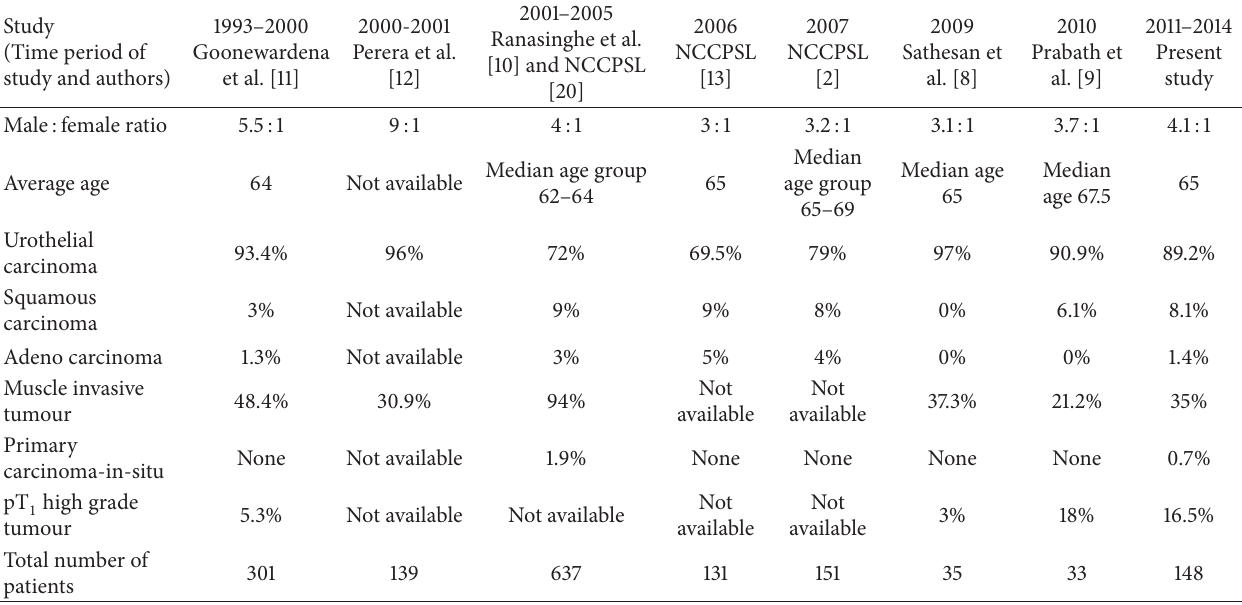
Table 1: Summary of results from published studies on bladder cancer in Sri Lanka.